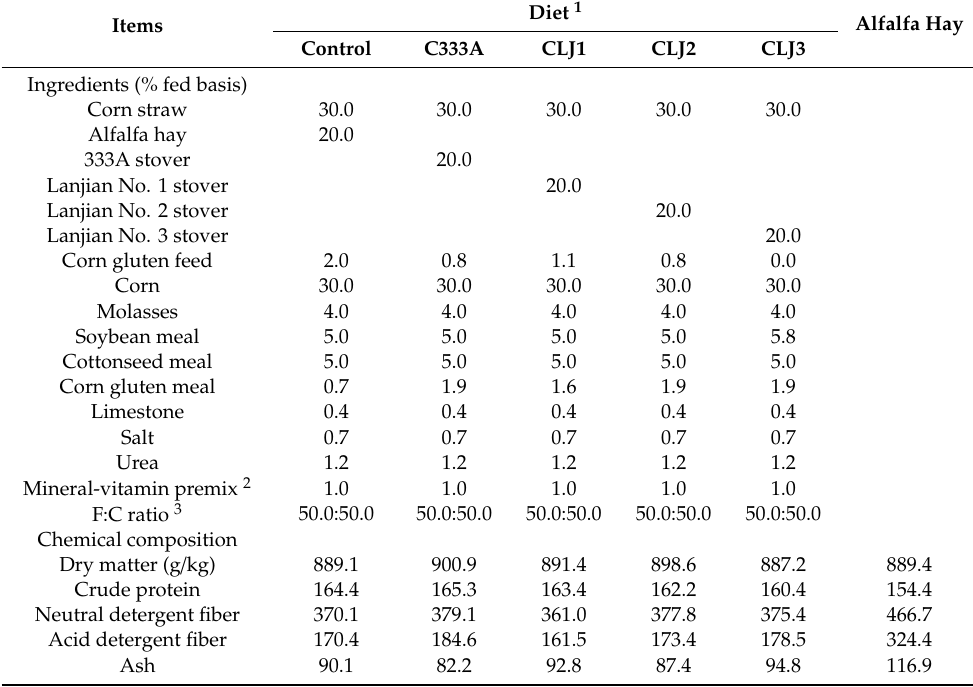
Table 1. Ingredients and chemical compositions (g / kg dry matter) of the experimental diet. Diet 1 Alfalfa Hay Items Control C333A CLJ1 CLJ2 CLJ3 Ingredients (% fed basis) Corn straw 30.0 30.0